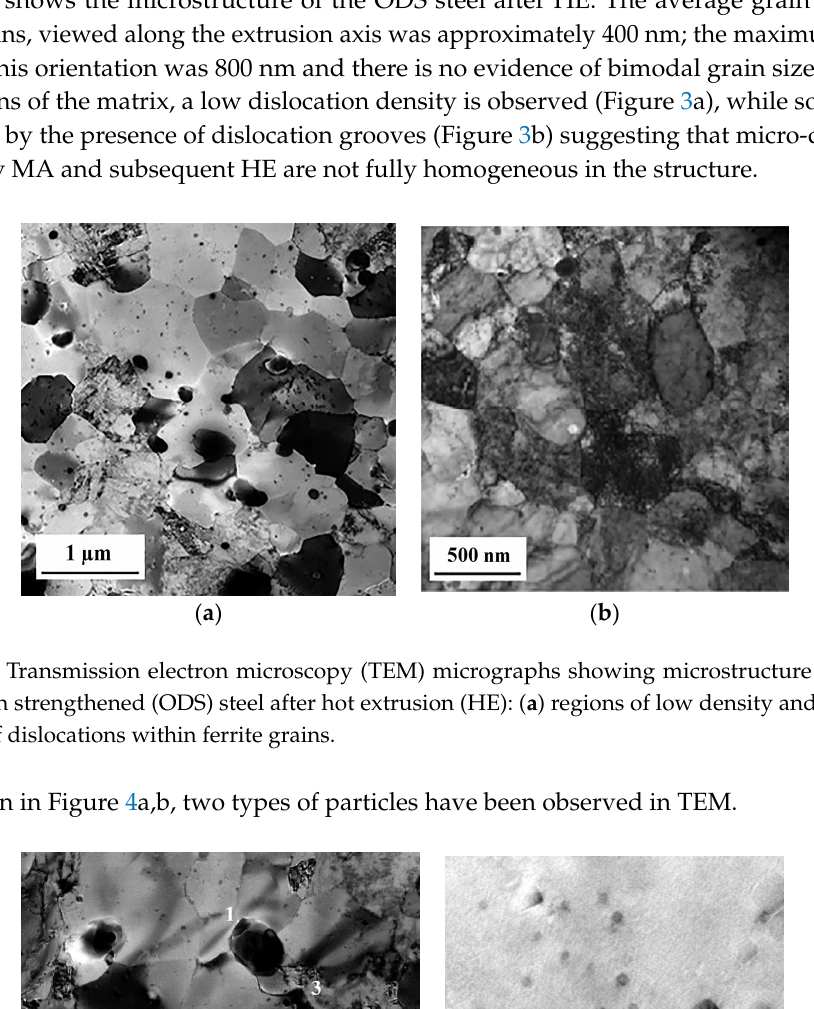
Figure 2. The {110} XRD peak profiles of the powder before and after hot extrusion.